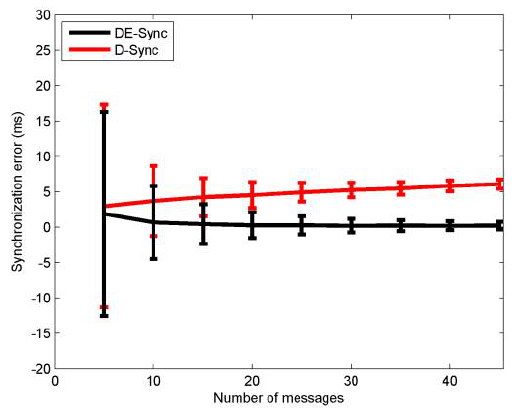
Figure 8. Performance vs number of messages.